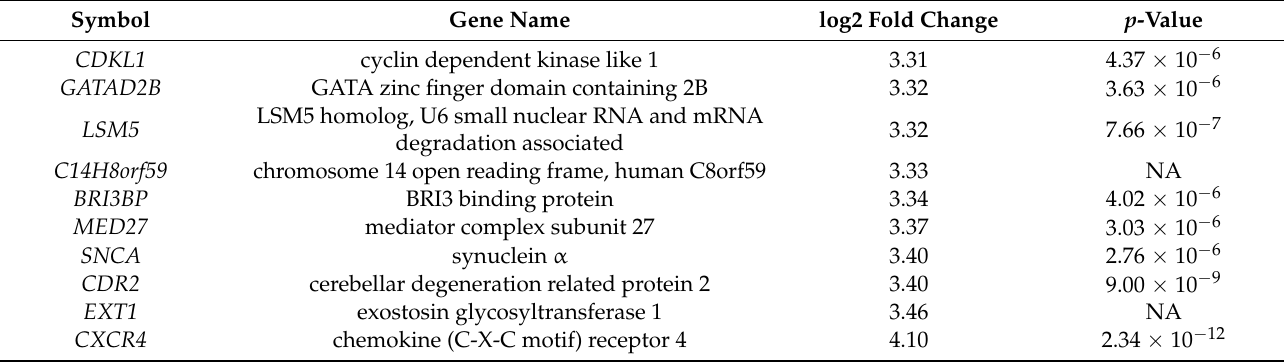
Figure 2. Heat map and cluster dendrogram of the 50 most differentially expressed genes. The scaled expression of each probe set, denoted as the row Z-score, is plotted on a green–blue color scale, with green indicating low expression and blue indicating high expression. Green (B)—embryos developed into blastocysts after biopsy; red (M)—embryos arrested as morulae after biopsy. Table 2. Top 10 genes expressed in embryos arrested at morula Table 1. Top 10 genes expressed in embryos developing into blastocysts.